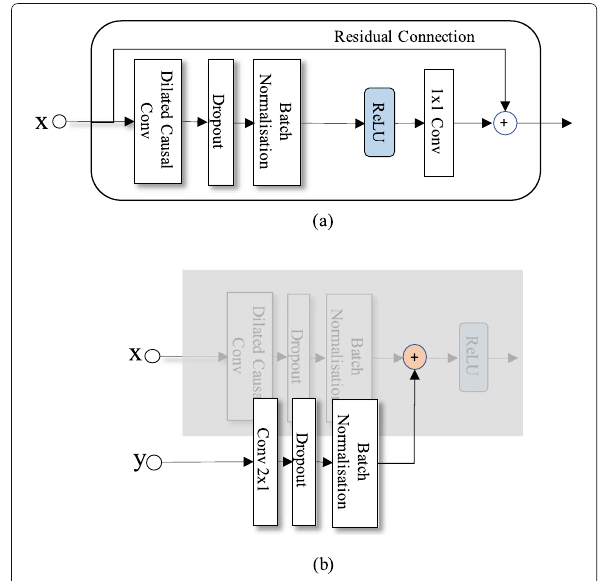
Fig.2a The dilatedcausalconvolutionblock. b The localconditioning